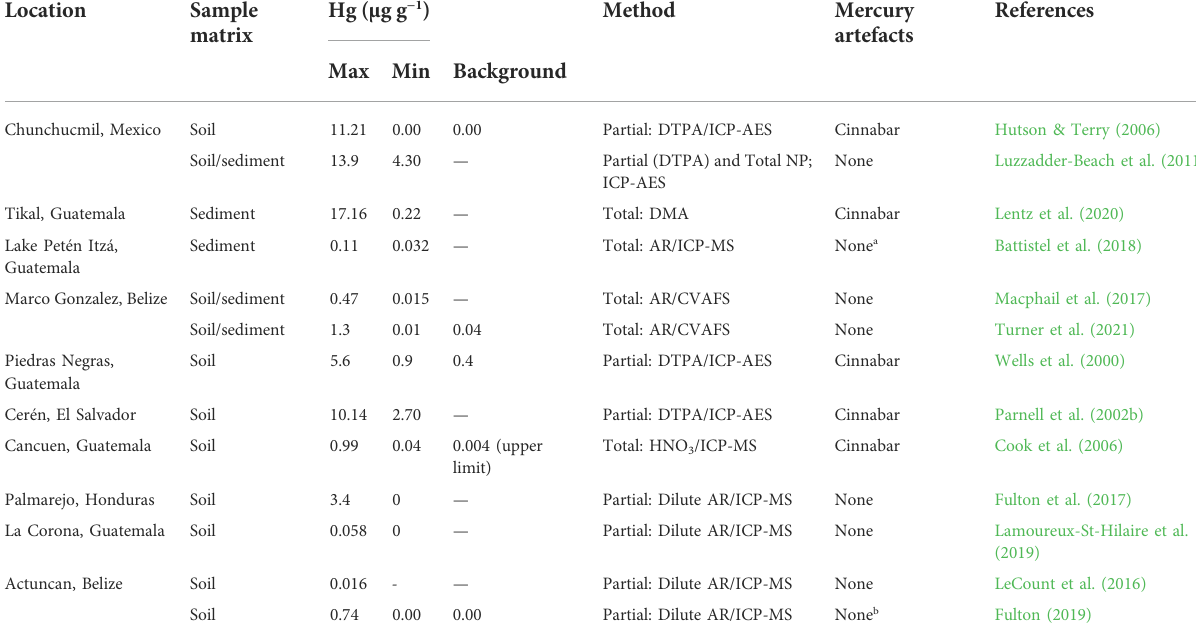
TABLE 3 Pre-Columbian Maya settlements with elevated environmental